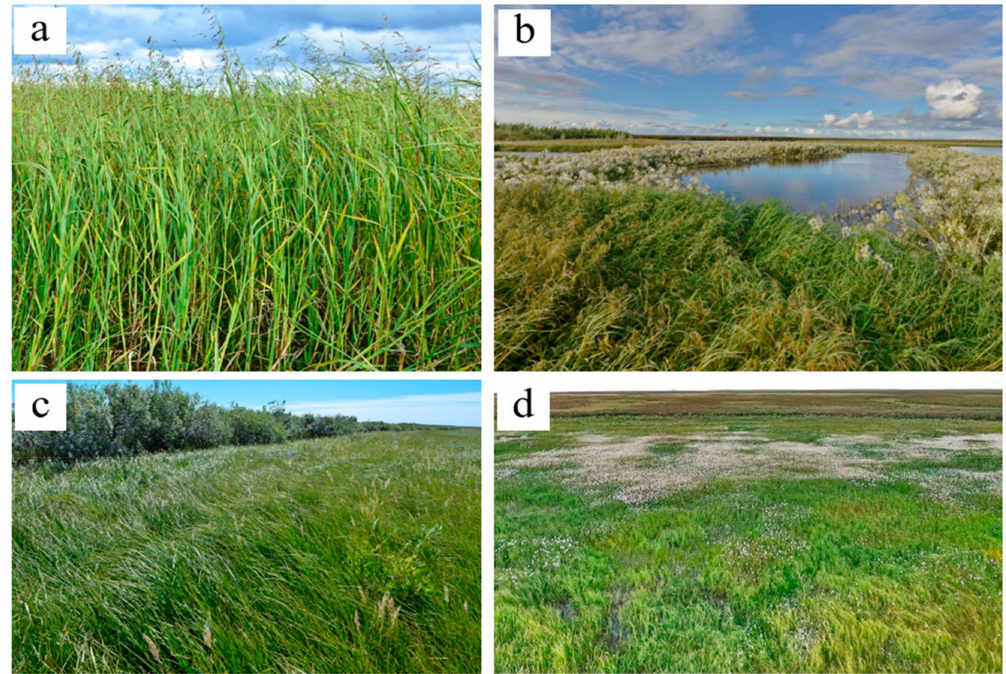
Figure 4. The vegetation of the early khasyreys: ( a )— Arctophila fulva ; ( b )— Arctophila fulva and Tephroseris palustris around the pond; ( c )—community on the sandbanks near the shore; ( d )—complex vegetation cover of the early khasyrey (green—sedge; white—cotton